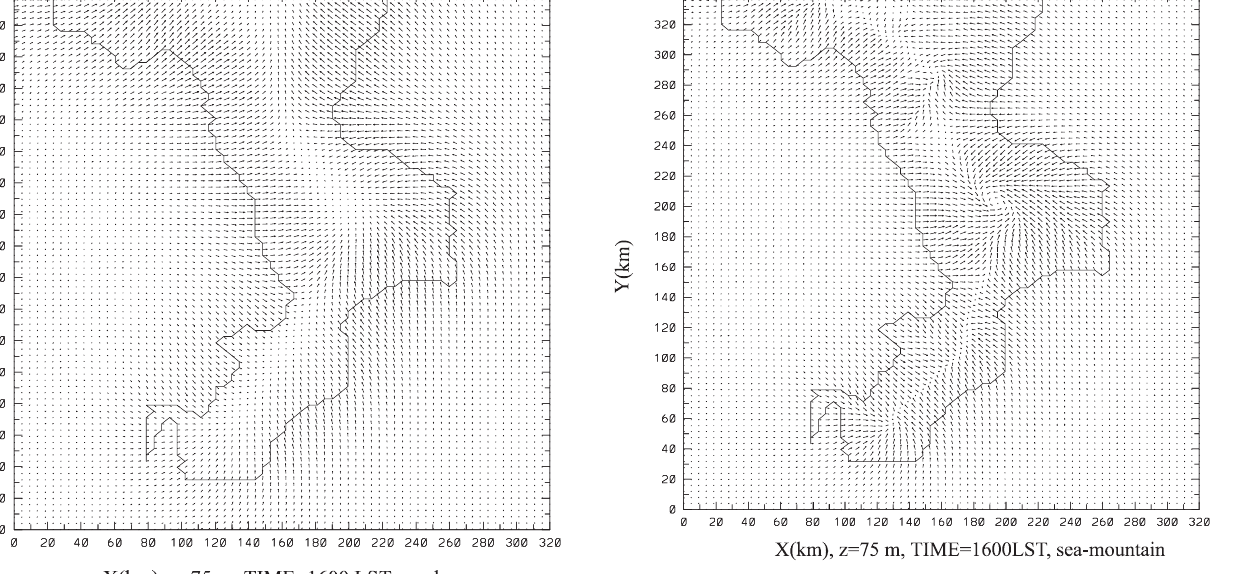
Fig. 8. Wind vector at 75 m above the ground simulated on July 16 at 16:00 LST for the sea-breeze case. u G (cid:136) 0 : 0 m